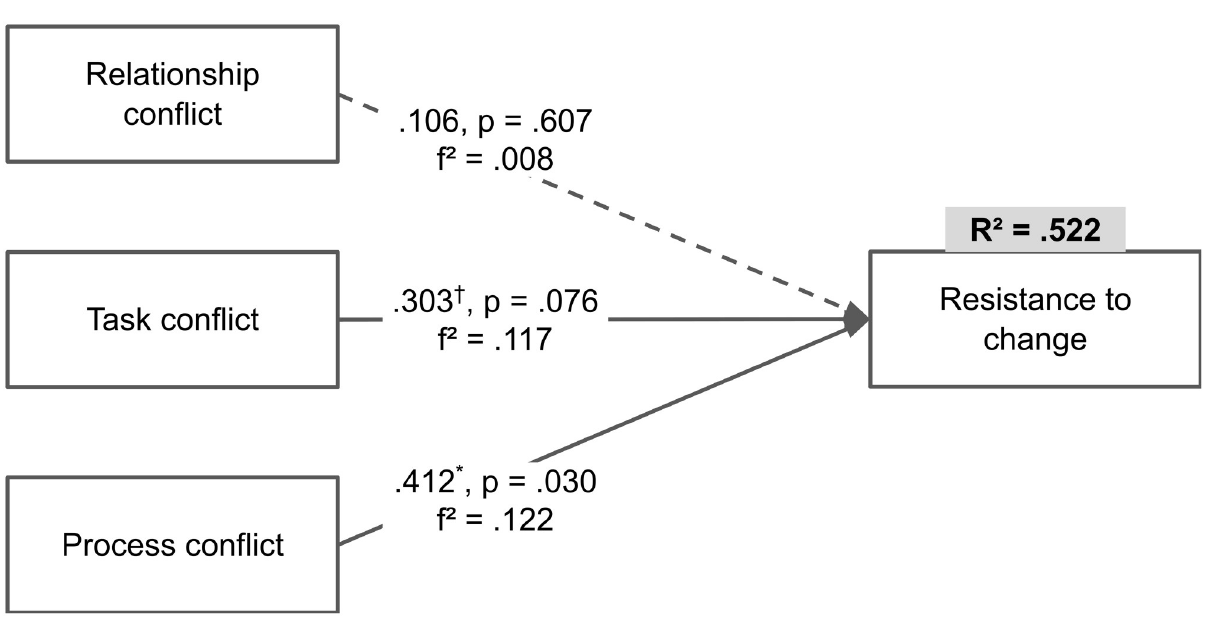
Fig 1. Structural model. Notes : † p < 0.10, � p <